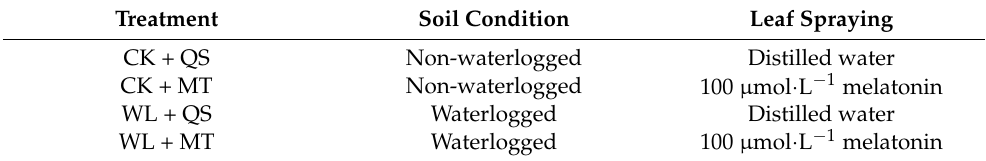
Table 1. Experimental design of soil condition and leaf spraying. Treatment